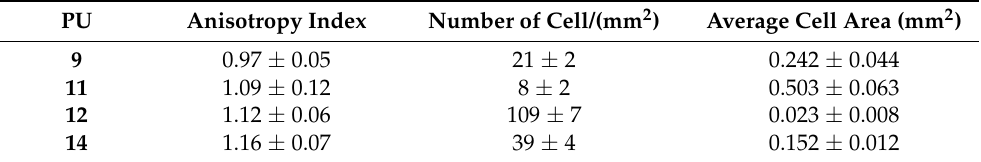
Figure 4. Scanning electron microscopy (SEM) images of structure of PUs and PU composites (× 100 magnification): ( a ) 9 , ( b ) 12 , ( c ) 10 , ( d ) 13 , ( e ) 11 , ( f ) 14 . Table 2. Characteristics of PU cellular